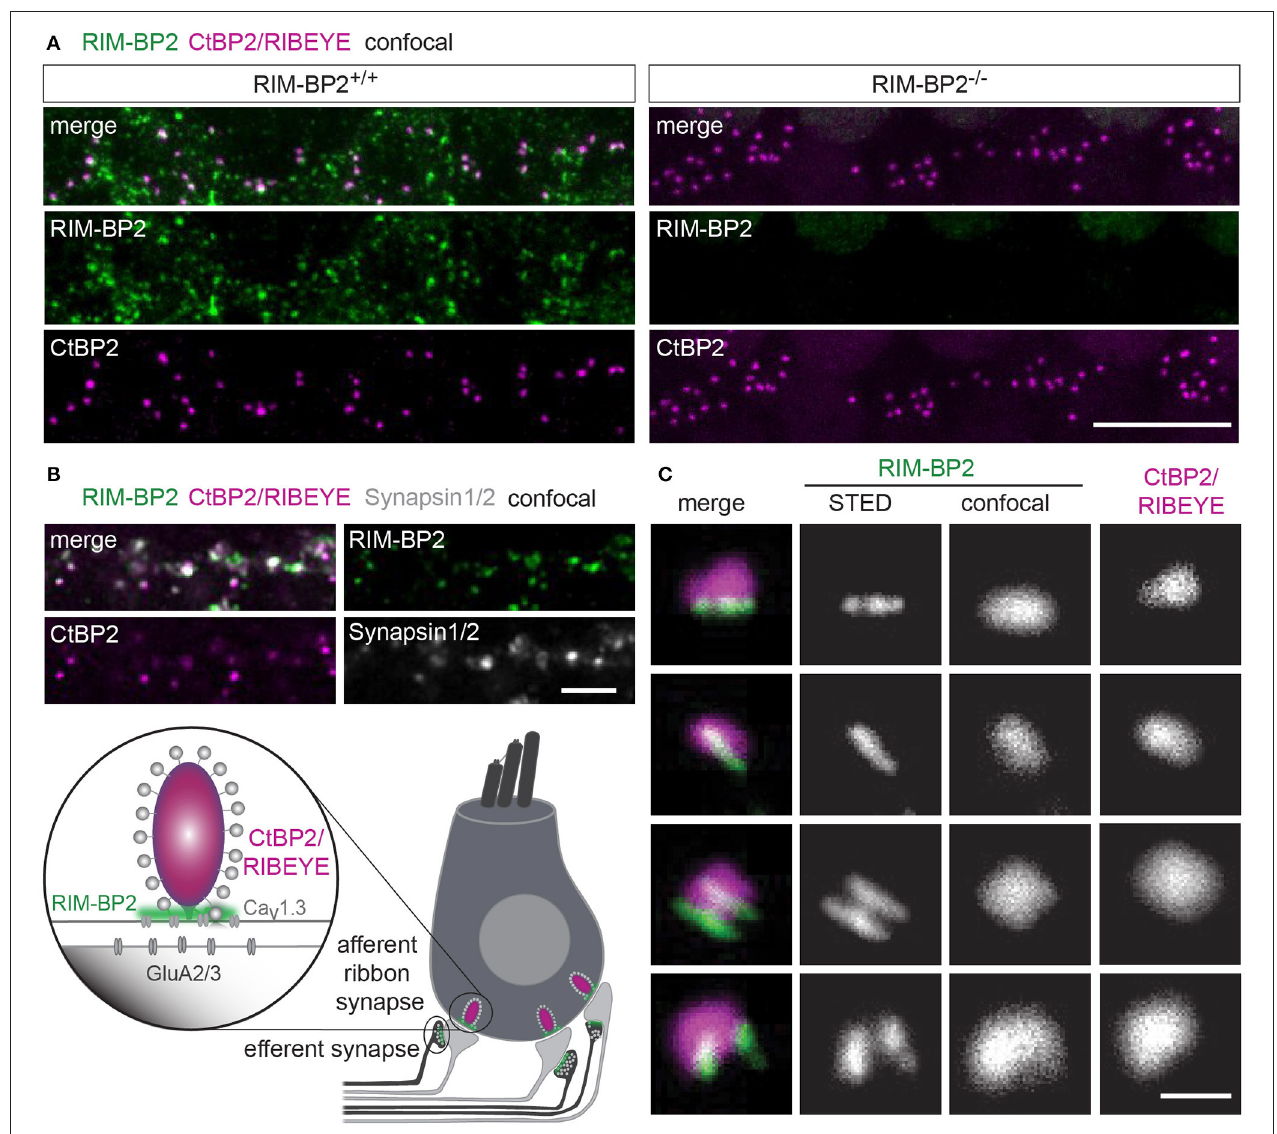
FIGURE 1 | RIM-BP2 forms stripe like clusters at the base of the synaptic IHC ribbon. (A) Expression analysis of RIM-BP2 in IHCs: Maximum projections of confocal stacks after immunohistochemistry of whole-mount explants of apical organs of Corti. RIM-BP2 immunofluorescence (green) co-localizes with presynaptic ribbons (CtBP2/RIBEYE, magenta) in RIM-BP2 + / + IHCs and is absent in parallel processed littermate RIM-BP2 − / − IHCs, indicating specificity of the immunolabeling. Additional RIM-BP2 fluorescence in RIM-BP2 + / + IHCs most likely localizes to presynaptic efferent terminals (B) . Scale bar: 10 µ m. (B) Top: Maximum projections of confocal stacks after triple-immunostaining of whole-mount explants of apical organs of Corti. RIM-BP2 immunofluorescence (green) co-localizes with either presynaptic ribbons (CtBP2/RIBEYE, magenta) or Synapsin1/2 (gray) marked presynaptic terminals of efferent lateral olivocochlear neurons. Scale bar 5 µ m. Bottom: Illustration of a mature murine IHC: Afferent type I SGNs innervate ribbon synapses at the IHC base. Efferent synapses of the lateral olivocochlear neurons form projections onto type I SGN synapses nearby the IHC. Location of presynaptic ribbons (CtBP2/RIBEYE) is highlighted in magenta. RIM-BP2 (green) forms clusters at the presynaptic density at the base of the synaptic ribbon and at the AZs of efferent presynaptic terminals. (C) Nanoscale organization of RIM-BP2: 2-color STED microscopy of individual active zones from whole mount explants of apical organs of Corti after immunohistochemistry resolved a mostly stripe or double-stripe-like expression pattern of RIM-BP2 (green) at the ribbon (CtBP2/RIBEYE, magenta). Simultaneously acquired confocal images could not resolve single or double stripes of RIM-BP2. Single XY-sections, scale bar: 500nm. (A–C) Age of mice: